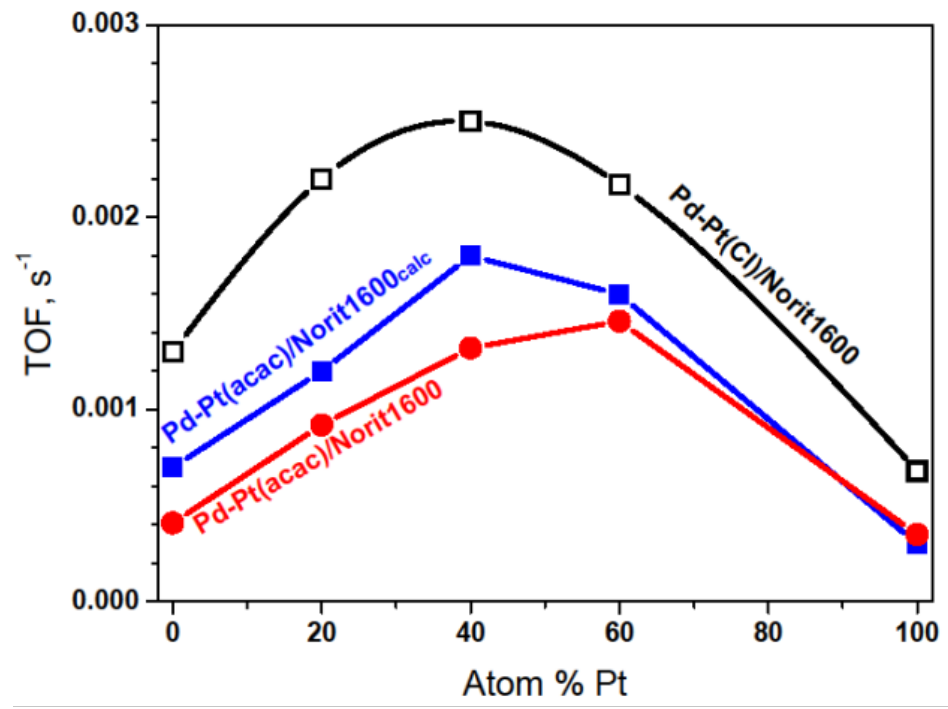
Figure 9. Catalytic activity (TOFs) of the Pd–Pt / Norit1600 catalysts vs. nominal Pd–Pt alloy composition.